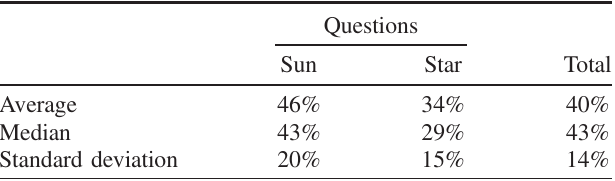
FIG. 4. Question II.F: None of the written explanations was correct, even when the correct answer was